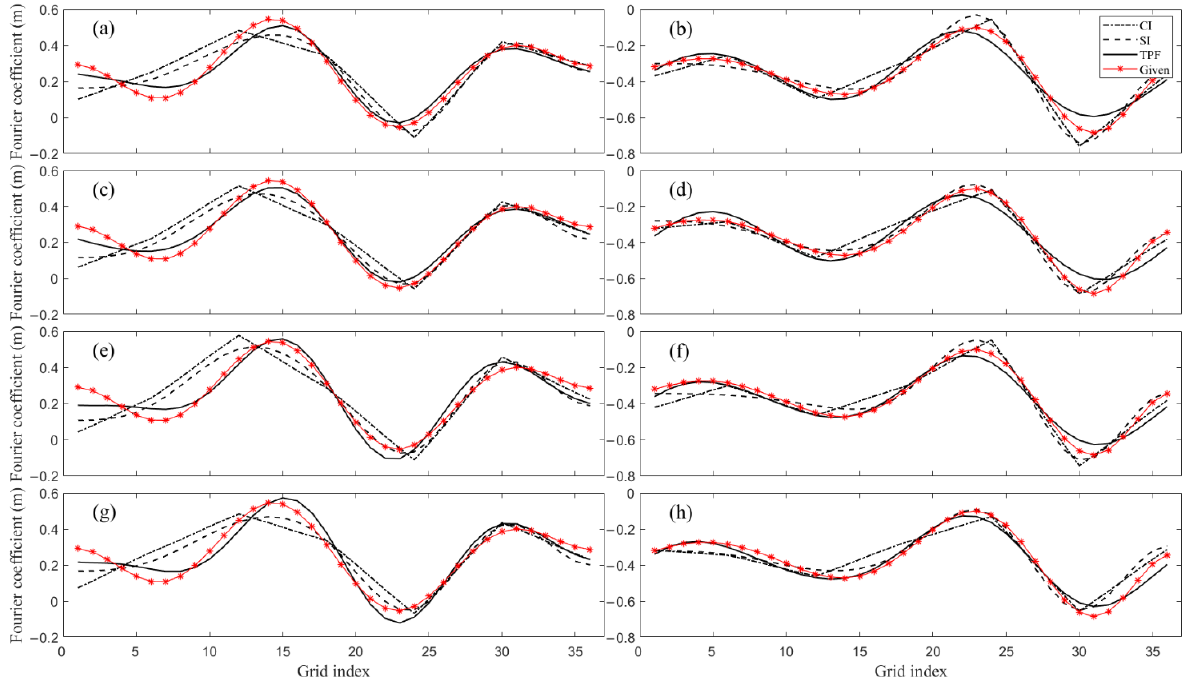
Figure 5. Given and inverted FCs of TE-5 α ( a ) and β ( b ), TE-6 α ( c ) and β ( b ), TE-7 α ( e ) and β ( f ), and TE-8 α ( g ) and β ( h